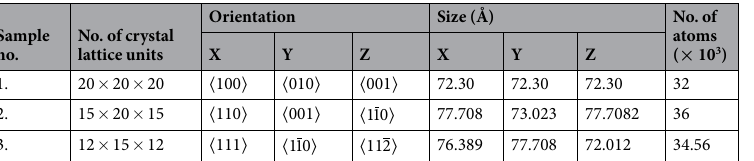
Table 2. Necessary details of the initial configurations of the samples with desired orientations used for EAM MD simulations. The mass density of all the samples are 8.806 g/cm 3 at ambient temperature and pressure.